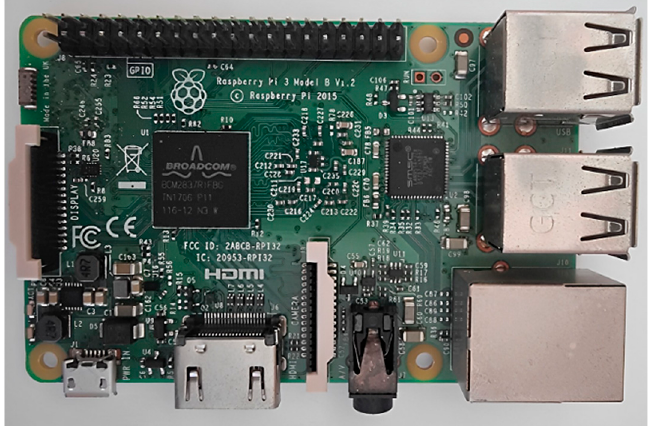
Figure 5. The Raspberry Pi 3 model B used to realize the proposed home gateway.